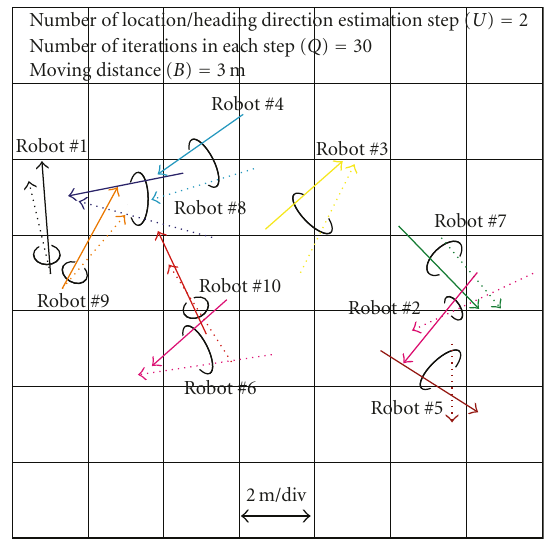
Figure 13: Example of estimated heading directions for 10